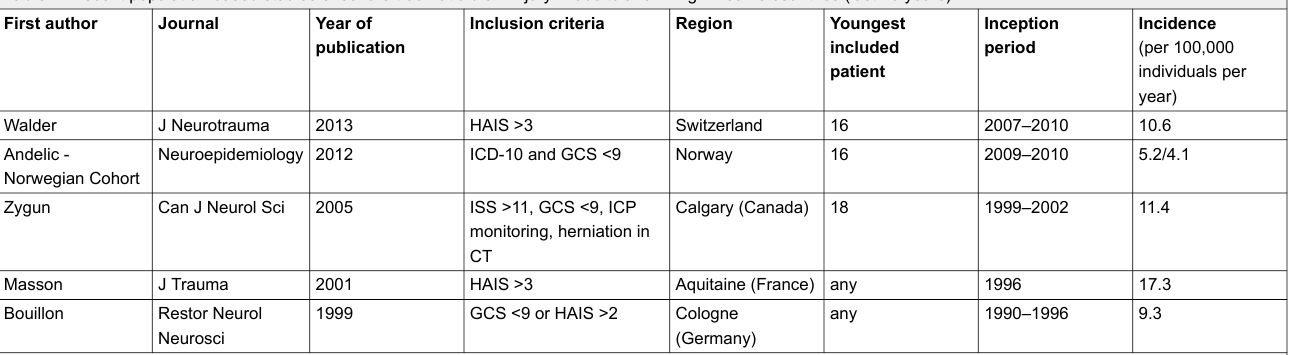
Table 1: Recent population-based studies of severe traumatic brain injury in adults and in high-income countries (last 20